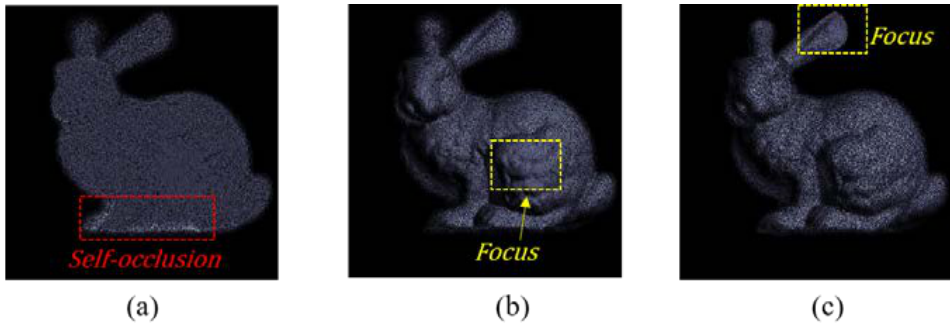
Figure 7. Numerical reconstruction of the bunny. ( a ) Focus on leg without shading, ( b ) focus on leg with shading, ( c ) focus on ear with shading.